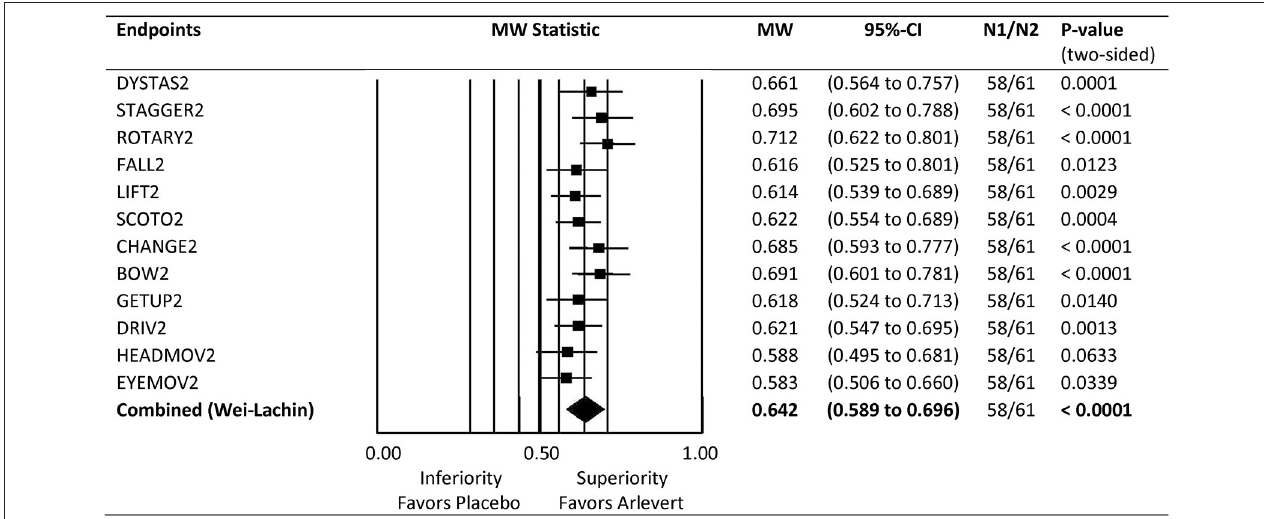
FIGURE 1 | Forest plot of Mann-Whitney (MW) effect size measures for comparison of Arlevert with Placebo after 4 weeks of treatment. Results are given for single endpoints and combined (composite) endpoint. MW: MW effect size measures; Wilcoxon test for single endpoints, directional Wei-Lachin test for combined endpoint. 95%-CI: lower and upper bounds of 95% confidence intervals. N1, N2: number of patients treated with Placebo and Arlevert, respectively.